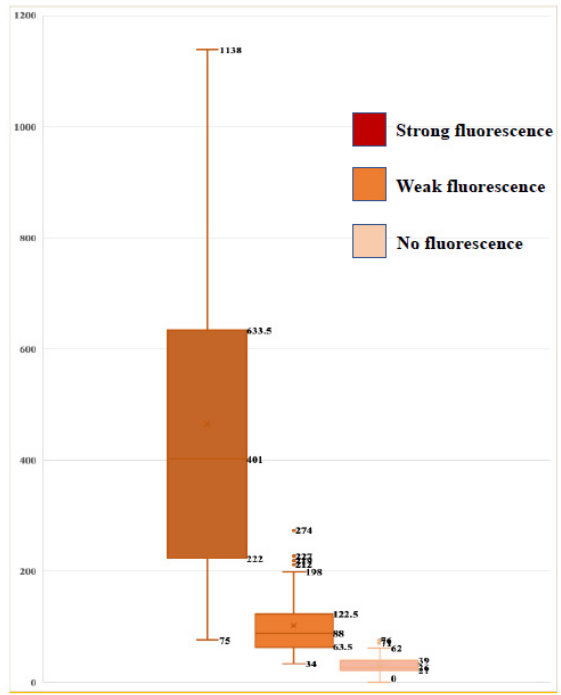
Figure 7. Association between fluorescence intensity on photodiagnosis using surgical microscope, and cell count determined by fluorescence emission on fluorescence microscopy. There was a statistically significant difference between the strong fluorescence and the weak fluorescence group ( p < 0.001), and the weak fluorescence and no fluorescence group ( p < 0.05) (Student t -test).